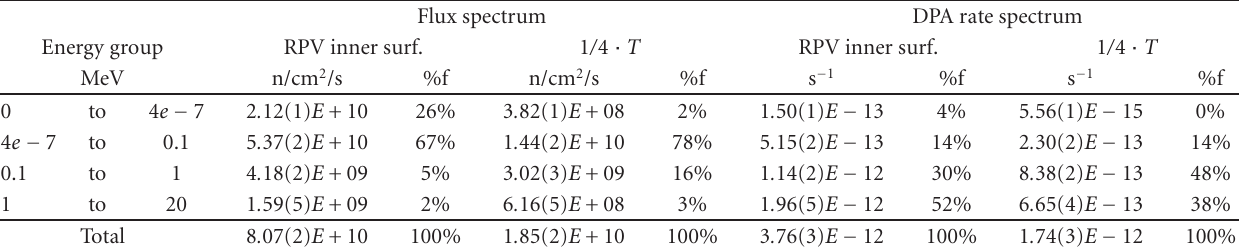
Table 1: Flux and DPA rate spectrum for R = 369 . 5cm (RPV inner surface) and R = 377 . 0cm (1 / 4 · T